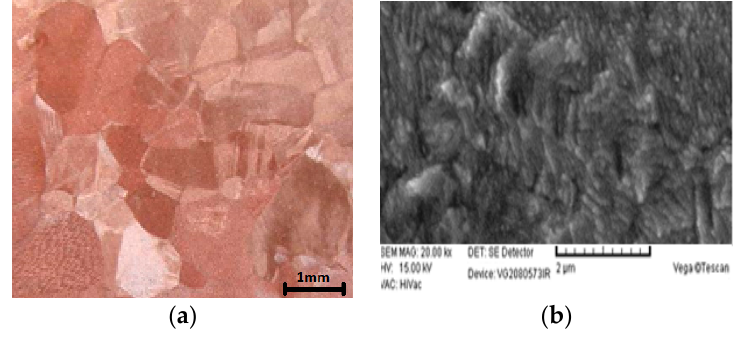
Figure 3. The Optical and SEM microstructure of annealed and nanostructure copper. ( a ) Annealed coarse grained copper; ( b ) Nanostructured copper